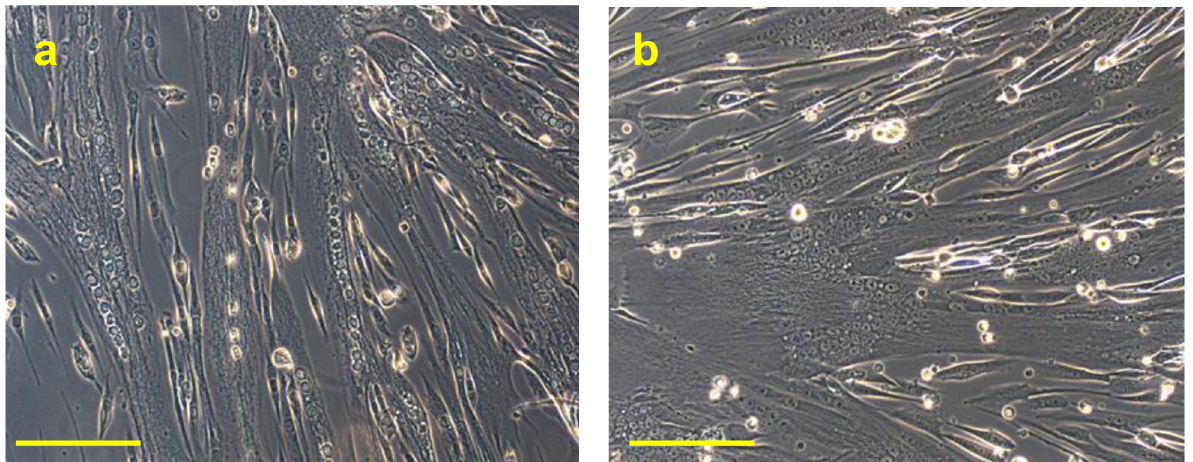
MHC protein expression was detected in hSCs di ff erentiated in myotubes, treated or not with 10 − 7 mol/L PTH (1-84) for 30 min, after 6 days of myogenic di ff erentiation and data are expressed as ng/mg of proteins. Figure 7. Representative observations acquired in phase-contrast microscopy of the myotubes, obtained by hSCs untreated ( a ) or treated ( b ) with 10 − 7 mol/L PTH (1-84) for 30 min, after 6 days of myogenic di ff erentiation. Objective 20×, scale bar 50 µm.